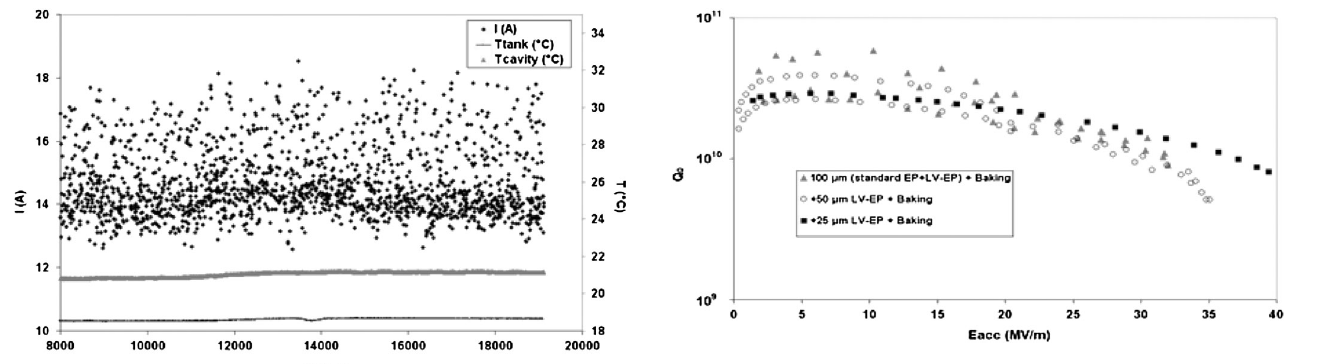
FIG. 11. The rf tests at 1.4 K. Improvement of the gradient for C1-21 cavity after successive LV-EP sequences.